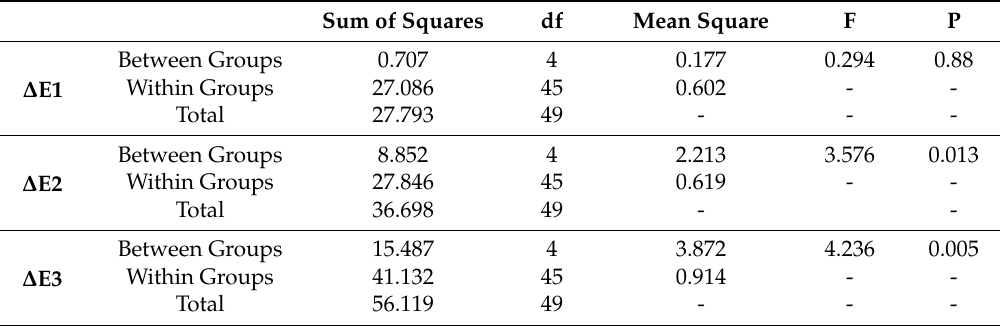
Table 2. Results of one-way (Analysis of Variance) ANOVA